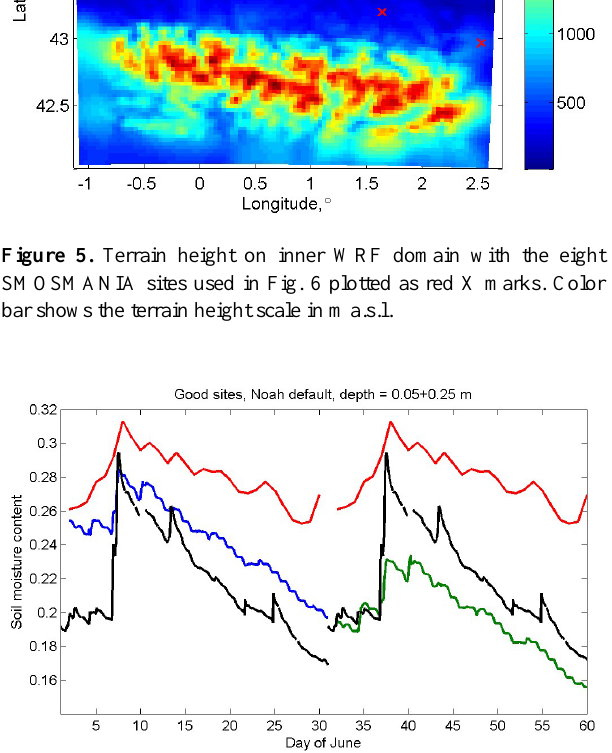
Figure 6. Average soil moisture for eight sites in the SMOSMANIA network. Each day of June appears twice on the horizontal axis to show the evolution through two cycles. Color scheme: black is ob- servations, red ERA-Interim, blue Noah cycle 1, and green Noah cycle 2.